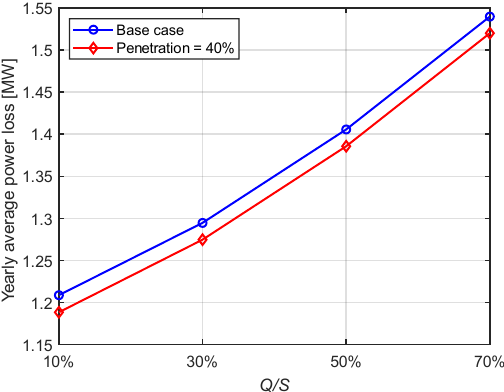
Figure 10. The yearly average power loss of the entire grid at different Q setpoints (with constant Q ).